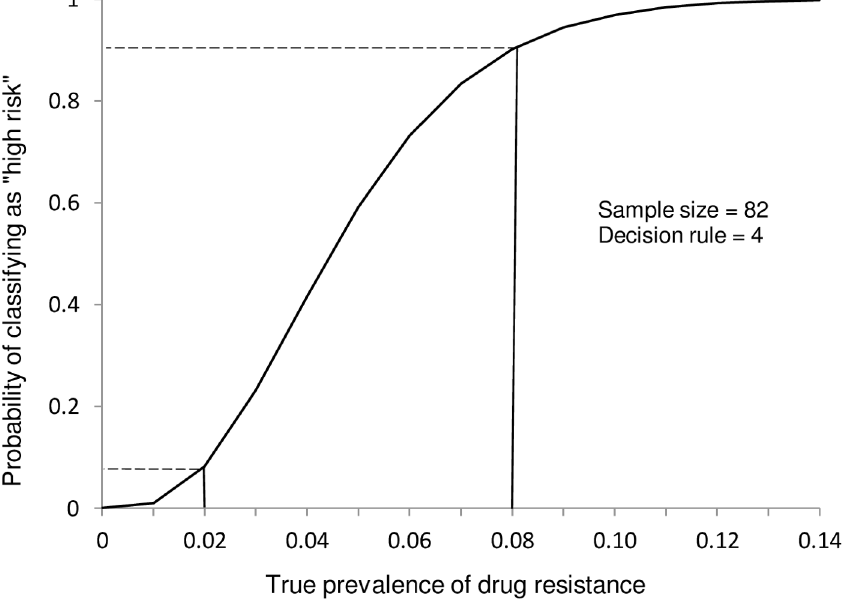
Fig 1. Operating characteristic curve for a sample size of 82 and decision rule of 4. The operating characteristic curve demonstrates that a sample size of 82 new TB cases and a decision cut-off of 4 achieves the desired misclassification properties ( < 10% misclassifications at a true prevalence of resistance of 8% and at a true prevalence of resistance of 2%).